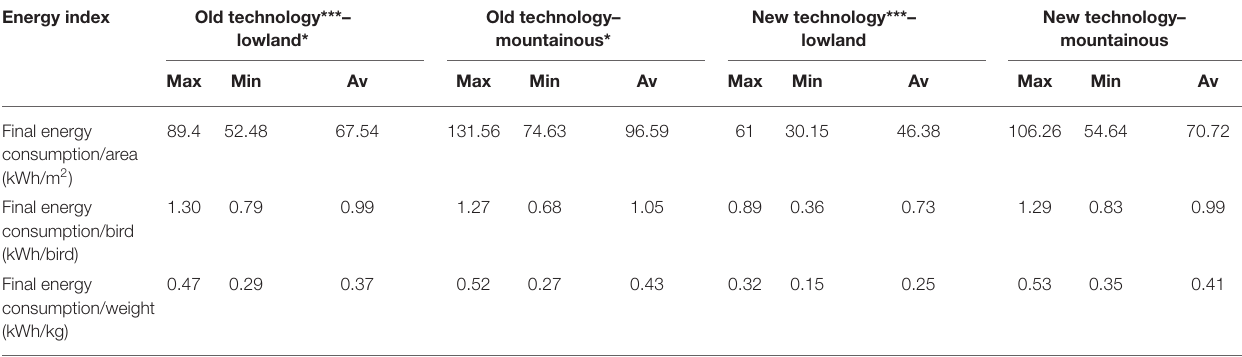
TABLE 4 | Energy indices according to the final energy consumption of the examined broiler